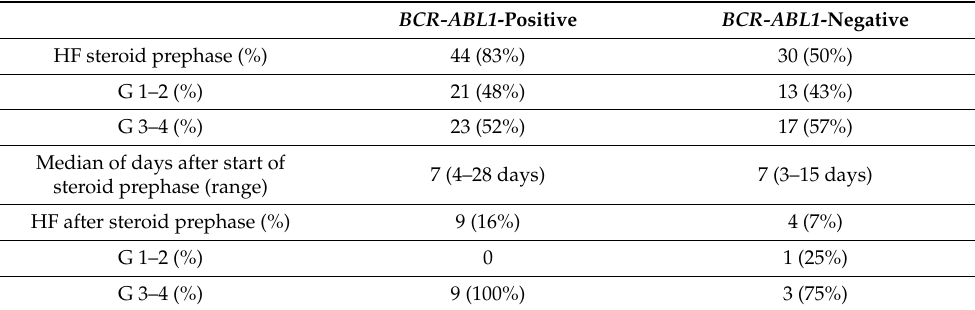
Table 2. Results in BCR-ABL1 -positive and negative